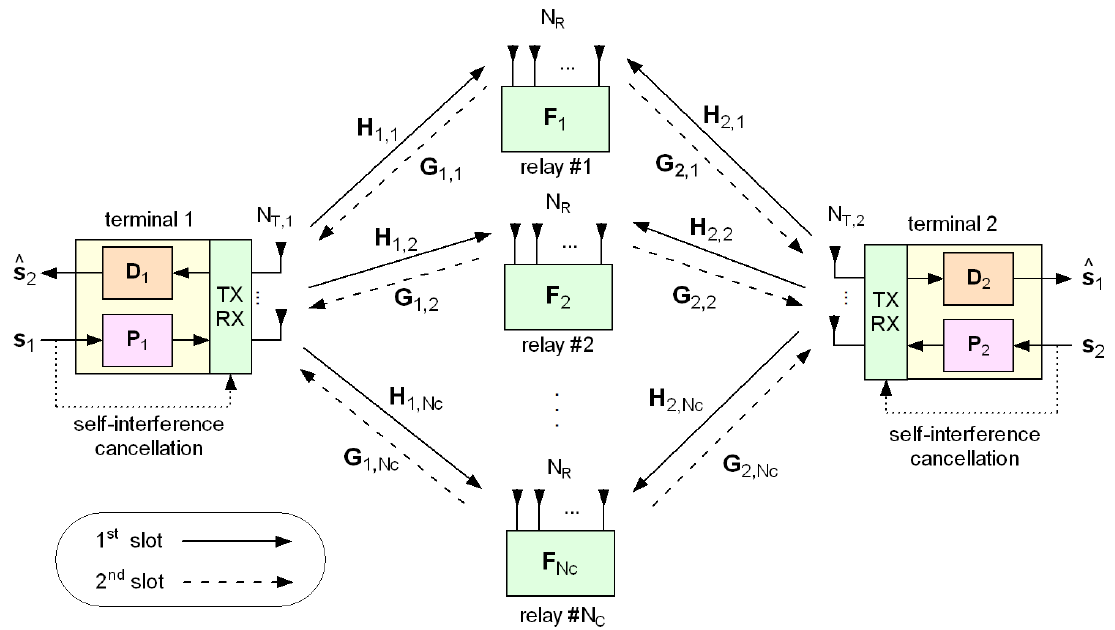
Figure 1. Model of the considered two-way relaying multiple-input multiple-output (MIMO) 5G